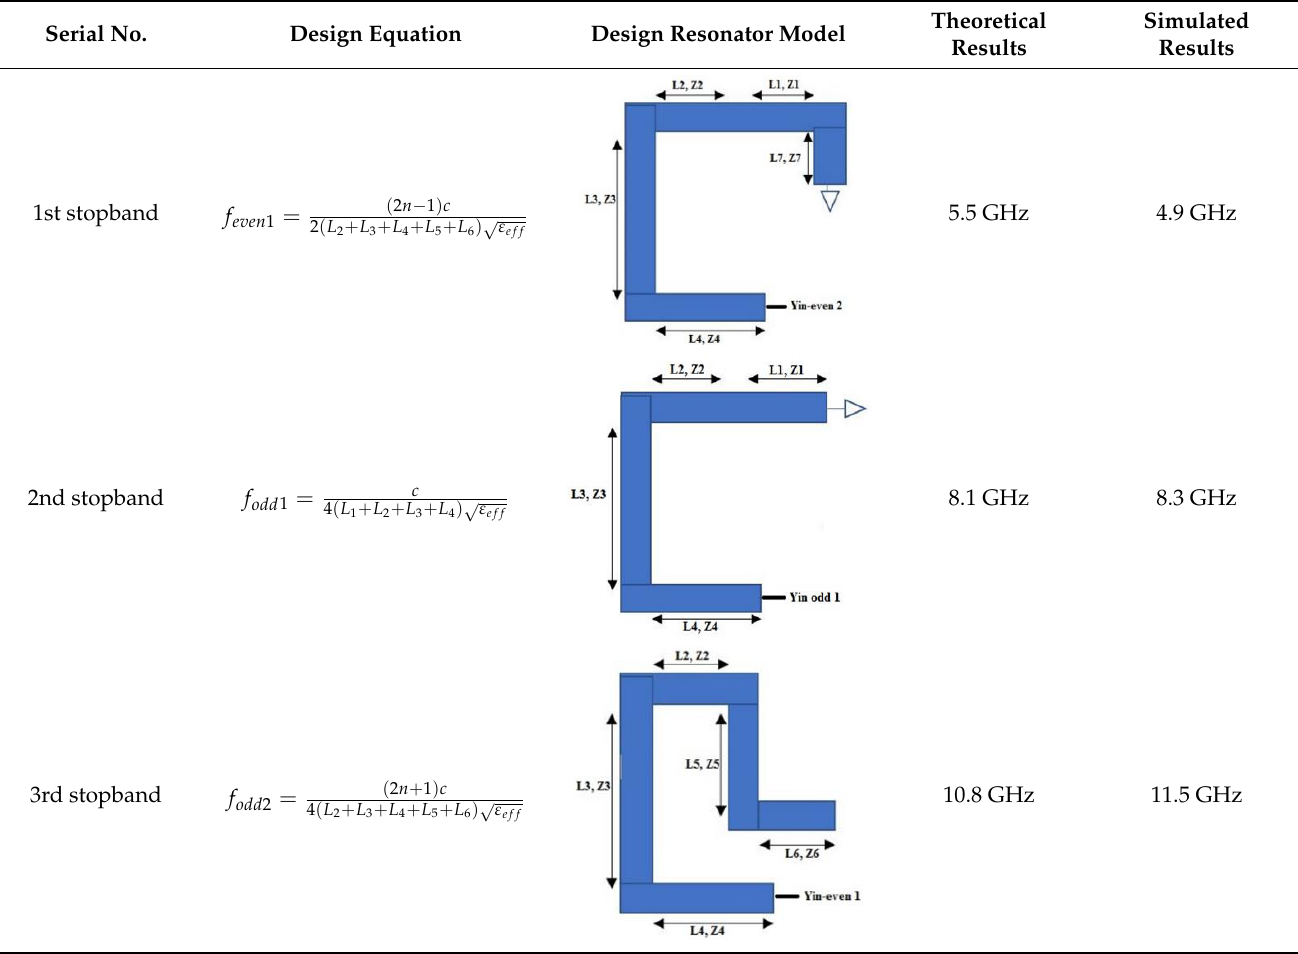
Figure 12. The presented architecture of the SUWB-BPF with a quad-mode stub-loaded resonator. Table 1. Dimensions in millimeter (mm) of the proposed SUWB-BPF with a stub-loaded resonator. Table 2. Design table for finding the stopbands of the proposed filter. Serial No.